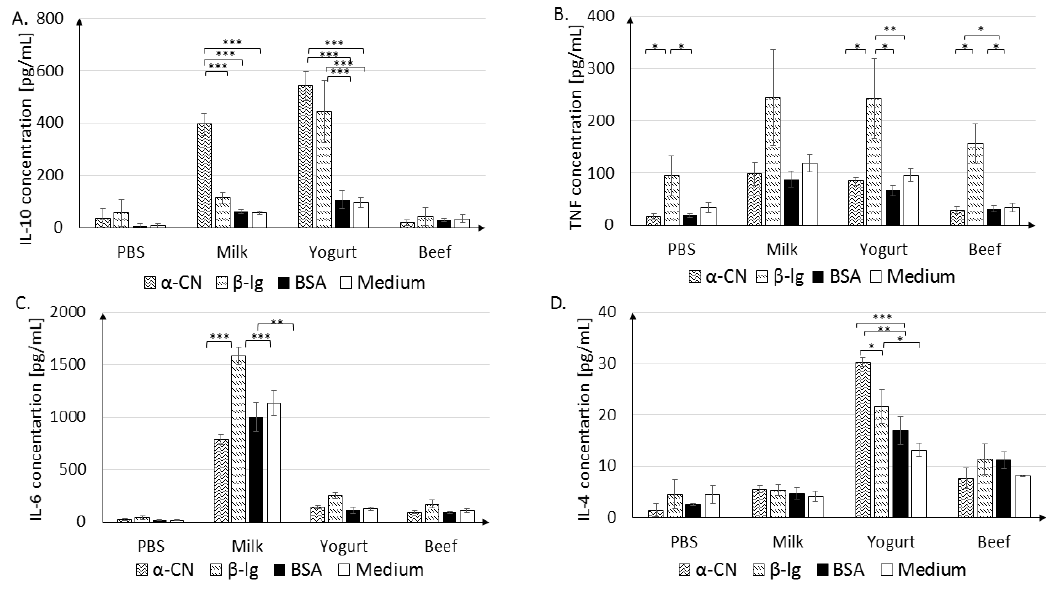
Figure 7. IL-10 ( A ), TNF ( B ), IL-6 ( C ), IL-4 ( D ) secretion in cultured splenocytes. Cells were stimulated with 100 μg/mL of α-CN, β-lg, or BSA, or grown in medium, and were incubated at 37 °C for 120 h. Data are the mean ± SD. * p < 0.05, ** p < 0.01, *** p < 0.001, one-way ANOVA with Tukey post-hoc